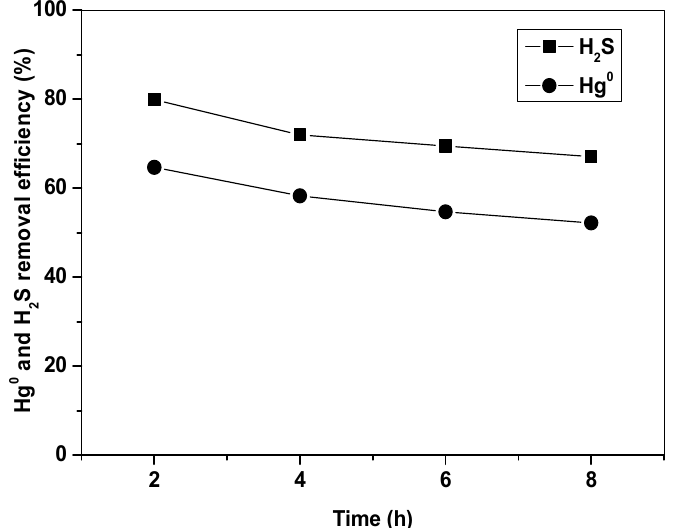
Figure 8. Removal of Hg 0 and H 2 S by Fe 2 O 3 /AC after regeneration. (Reaction condition: 10% H 2 , 15% CO, 1500 ppm H 2 S, balance N 2 , C Hg0 = 80 μ g/m 3 , GHSV = 15000 h − 1 , T = 150 °C.)